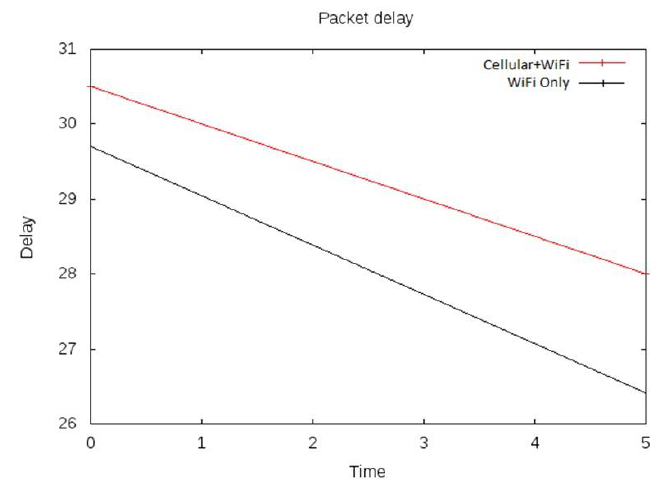
Figure 4. Time vs. delay